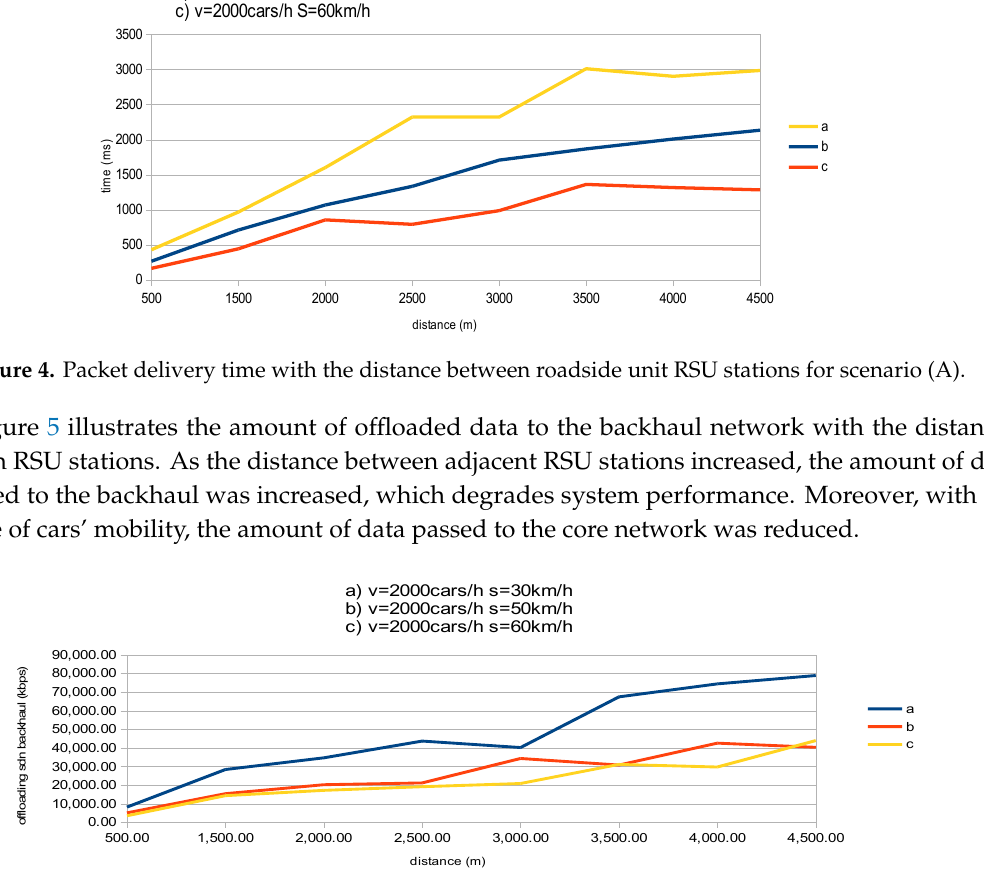
Figure 5. The rate of data offloaded to the backhaul network for scenario (A).